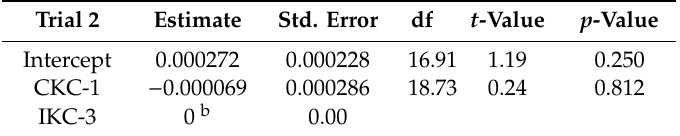
Table 13. The significant di ff erence of the mean of VR obtained in Trial 3 between CKC-1 and IKC-3. Trial 3 Estimate Std. Error df t -Value p -Value Intercept 0.000252 0.000108 13.17 2.33 0.037 * CKC-1 − 0.000371 0.000150 13.03 − 2.48 0.027 * Conditions = 2 0